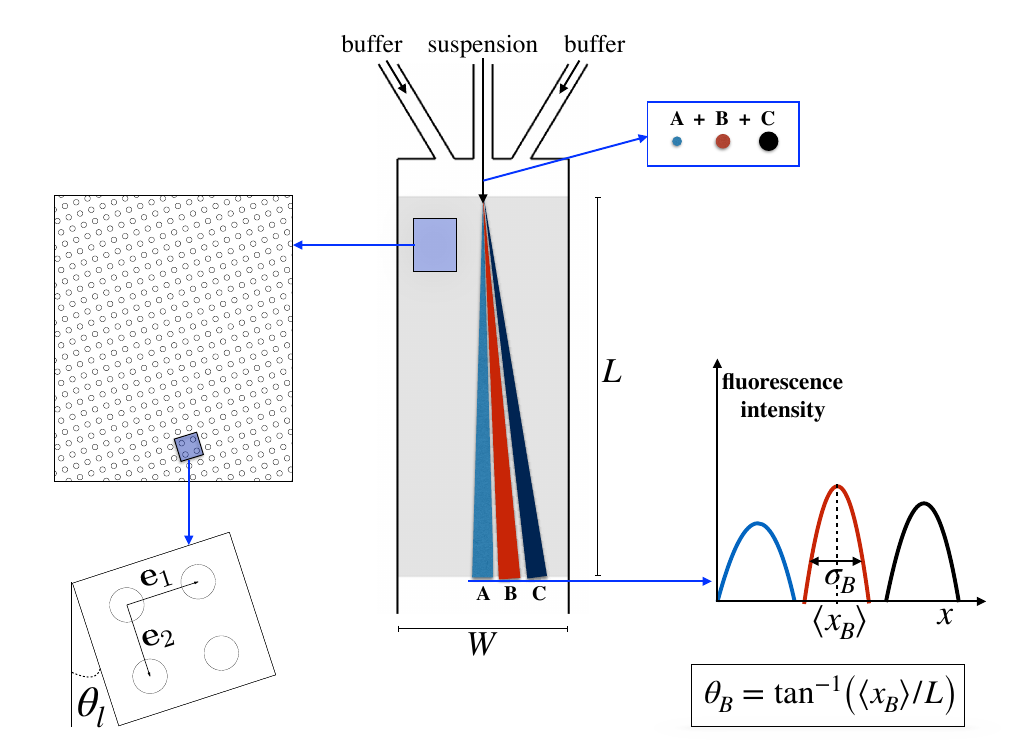
Figure 1. Schematic representation of a Deterministic Lateral Displacement (DLD) device. The suspension containing particles of different size is injected upstream the lattice (grey-shadowed area) and streams of size-sorted particles are collected at the lattice outlet. The particle migration angle, θ p , is defined based on the average displacement, (cid:104) x p (cid:105) , of particles of a given dimension to the lattice length L . Particle diffusion causes dispersion of the displacement of particles of one and the same size about the average value (cid:104) x p (cid:105) , which is quantified by the variance σ p